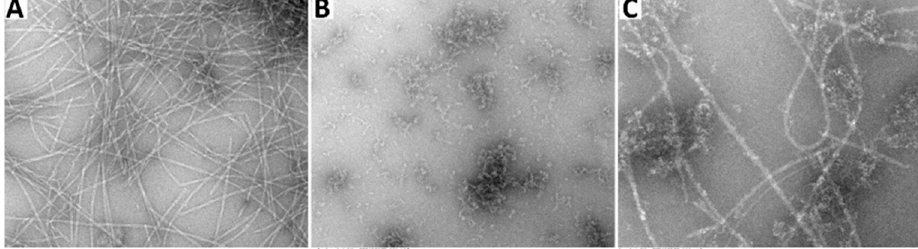
Figure 8. TEM images of ( A ) 0.25 wt% NapFFKKFKLKL (2), ( B ) 0.25 wt% NapFFDALDLTD (4), and ( C ) the mixture of 0.25 wt% NapFFKKFKLKL and 0.25 wt% NapFFDALDLTD. Scale bar is 100 nm.